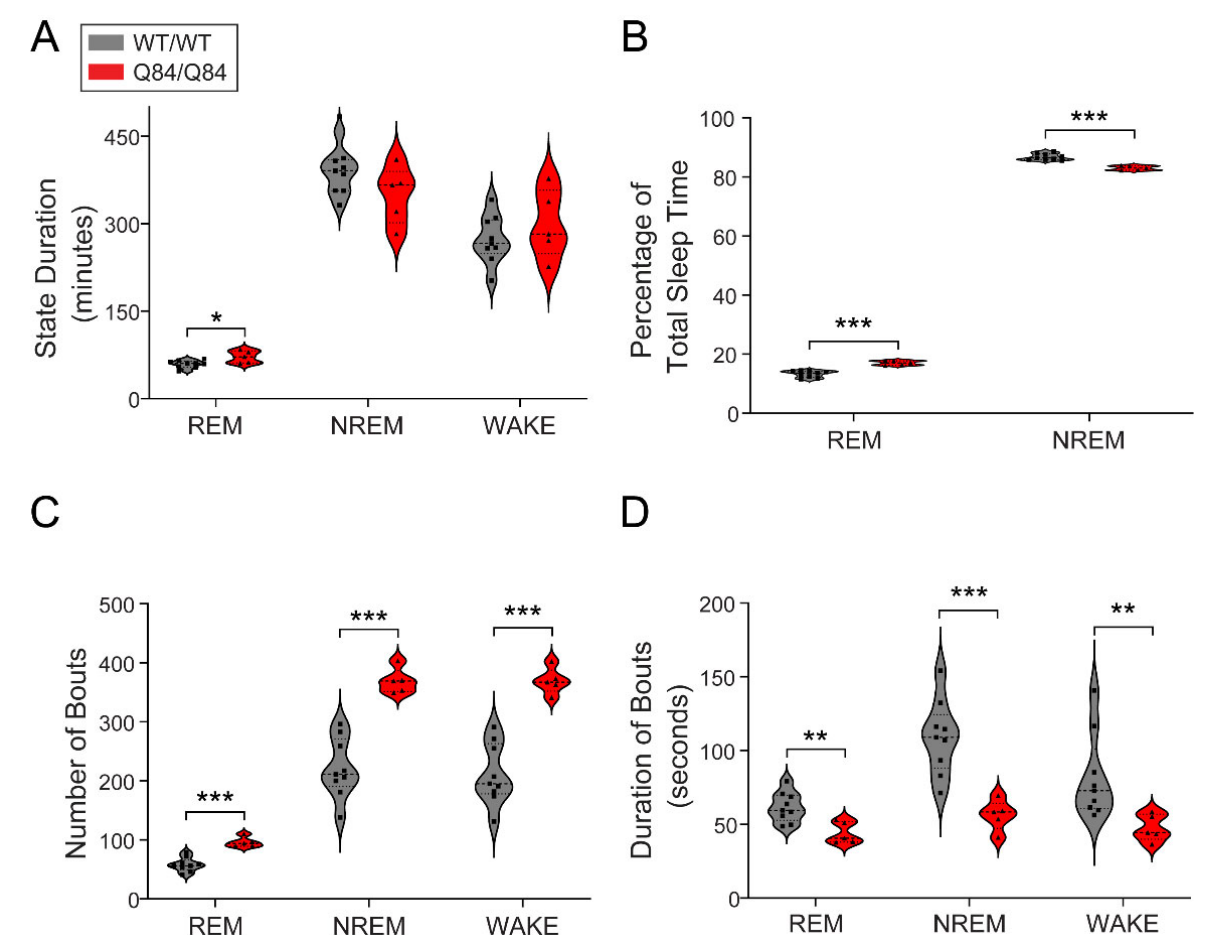
Figure 2. SCA3 Q84 mice show increased REM duration and sleep/wake fragmentation. ( A ) Homozygous Q84/Q84 mice (red, n = 5) reveal longer REM duration overall than wild-type WT/WT (grey, n = 9) littermates. ( B ) Homozygous mice show increased REM and decreased NREM percentages of total sleep time (TST) in comparison to wild-type mice. ( C ) Homozygous mice show more bouts of each state than their wild-type littermates. ( D ) In all states, homozygous mice display shorter bouts than wild-type mice. Thus, homozygous mice show that both sleep and wake states are composed of more bouts of shorter duration than wild-type mice. All violin plots display results from the 12 h lights-on period (zeitgeber time (ZT) 0–12), squares and triangles: individual values for wild-type and homozygous mice, dashed lines: median, dotted lines: quartiles. Statistical difference according to independent t -test or Mann–Whitney test. * p < 0.05, ** p < 0.01, *** p < 0.001, REM: rapid-eye movement sleep, NREM: non-REM. 3.4. SCA3 Mice Display Altered Neural Oscillations during REM and NREM Sleep Many movement disorders, including the synucleinopathies, display altered oscil- latory states during sleep relative to healthy subjects, even preceding clinical disease onset [39,40]. To quantify differences in brain EEG oscillations between SCA3 mice and controls, we used spectrographic analysis to quantify the power of all EEG oscillations across sleep (REM and NREM) and wake states (Figures 3–5). Visual examination of the spectrograms of all Q84/Q84 mice revealed the presence of beta power during REM and NREM (Figure